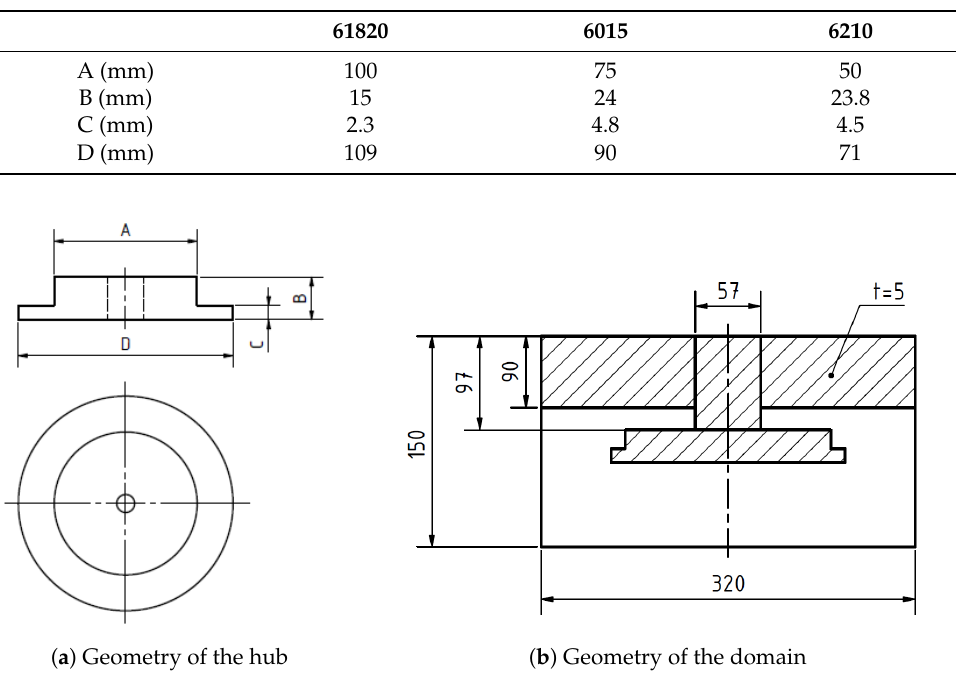
Table 2. Hub dimensions.